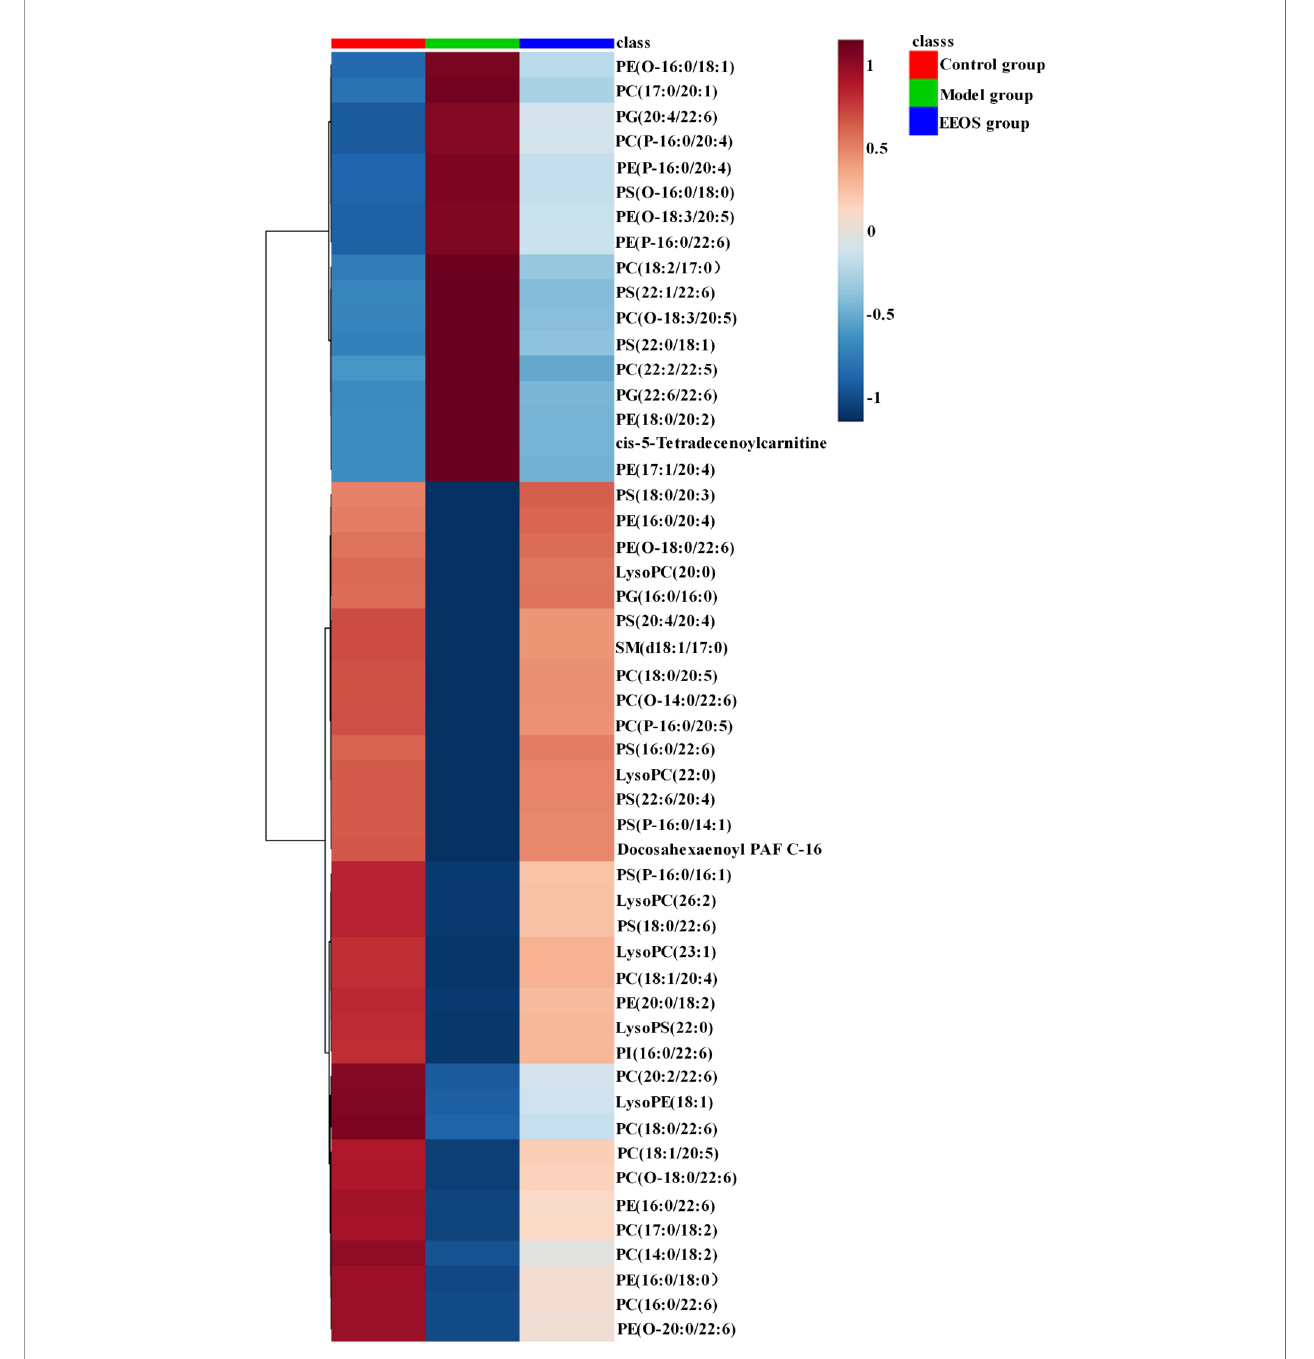
FIGURE 4 | Hierarchical clustering analysis of three groups kidney samples. The lipid pro fi les of the control group and the model group were obviously different, while the lipid pro fi les of the control group and the EEOS group were similar. The depth of color represents the relative intensity of the lipid